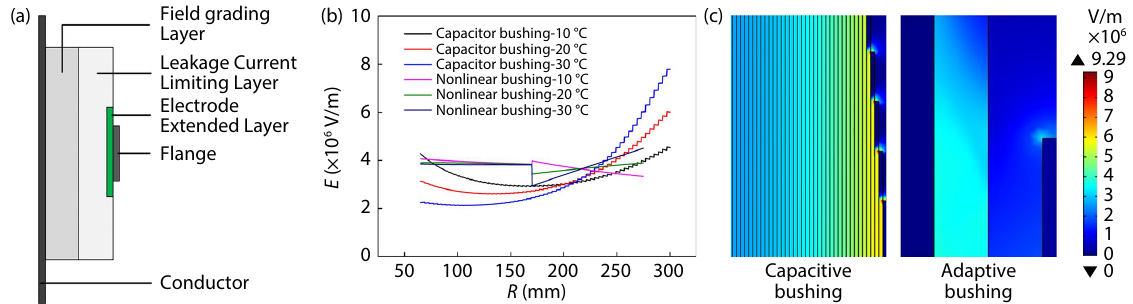
Fig. 7 Design of adaptive bushing based on SADs. ( a ) Structural diagram of adaptive bushing. ( b ) Radial electric field distribution under various temperature dif- ferences. ( c ) Electric field distribution of the capacitive bushing and adaptive bushing. Reprinted with permission from ref. [34], © 2021 The